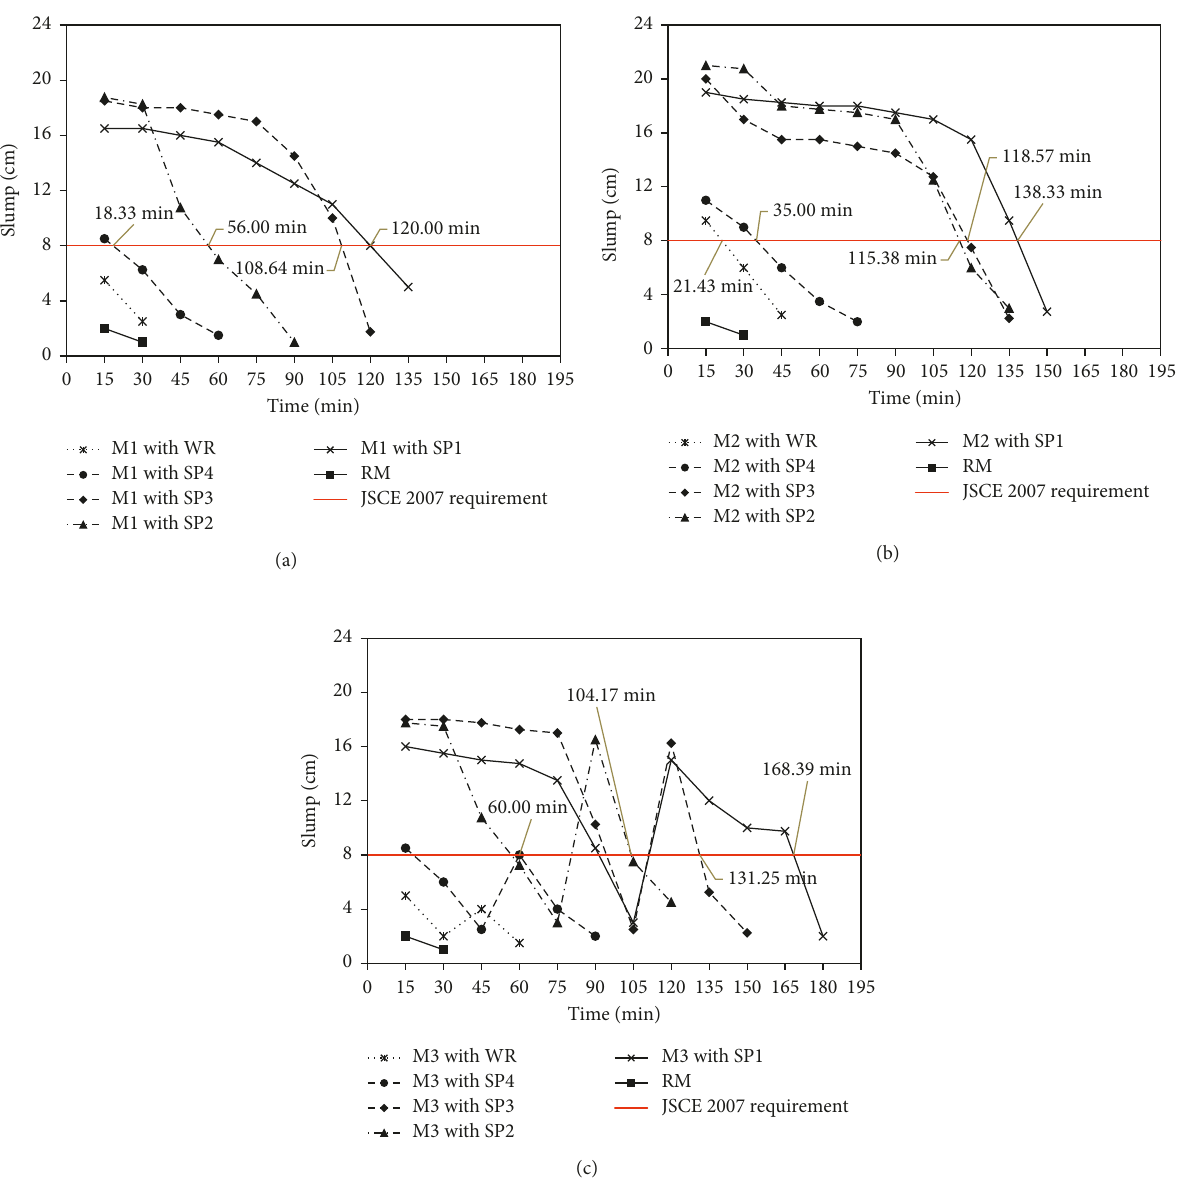
Figure 2: Slump test results of RM, M1, M2, and M3 mixtures (W/C (cid:136) 0.40, s/a (cid:136) 0.40, and C (cid:136) 340 kg/m 3 ): (a) M1 (cid:136) average dosage of admixture, RM (cid:136) no admixture; (b) M2 (cid:136) maximum dosage of admixture, RM (cid:136) no admixture; (c) M3 (cid:136) maximum dosage of admixture in two stages, RM (cid:136) no